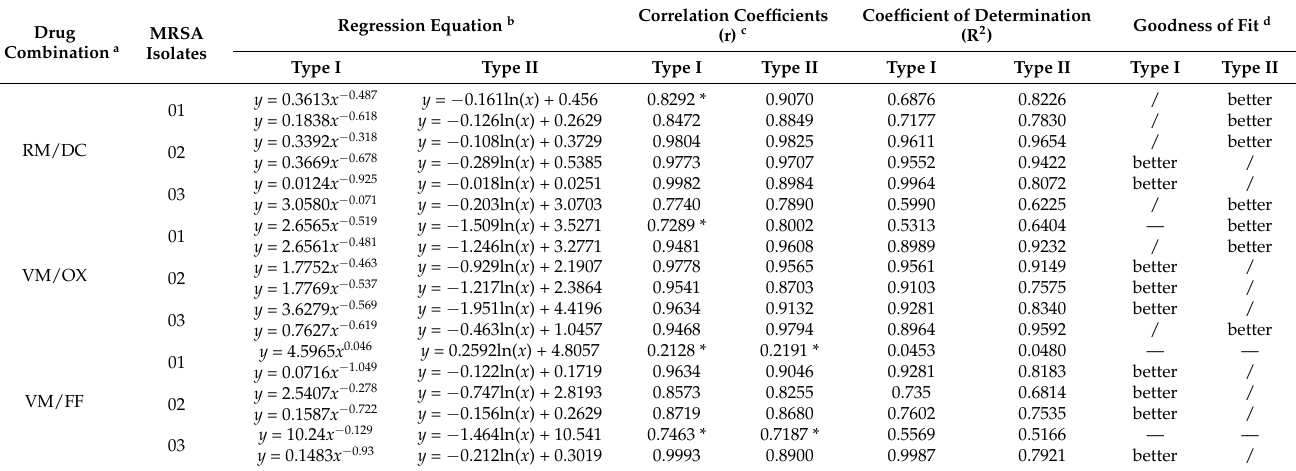
Table 1. Correlation between the SI (y) of one agent in a drug combination and the ratio (x) of another to this agent. (n =